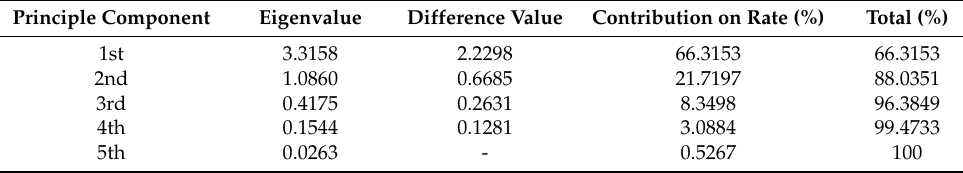
Table 2. Results of principle component analysis of cellular system